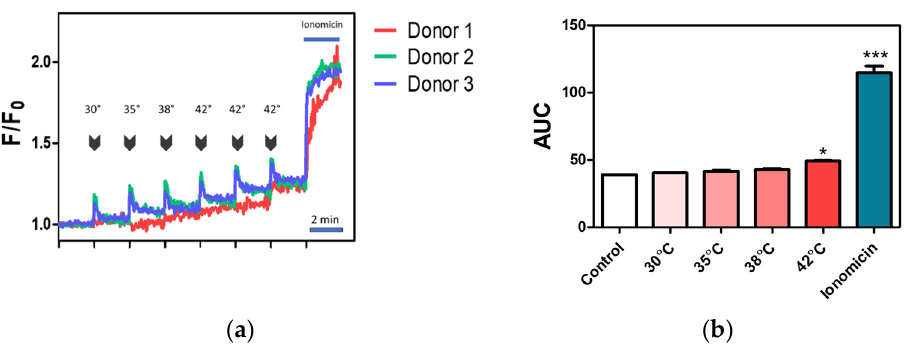
Figure 5. Temperature effect on intracellular calcium levels. ( a ) Relative calcium levels were measured using fluorescent calcium indicator Fluo-4. An increase in temperature was associated with raise in fluorescence intensity (associated with an increase in calcium levels). Ionomycin was used as a positive control. Calcium traces are presented as F/F0 ratio, n = 3. ( b ) Short (3 min) preincubation of cells at 42 °C temperature caused a significant increase in fluorescence intensity associ- ated with raise in intracellular calcium levels. Ionomycin at final concertation of 1 ng/mL caused a further increase in intracellular calcium. Bars represent mean ± s.e.m., n = 3 of the area under the curve (AUC) of calcium traces. Significant differences were denoted with asterisks, depending on the p- level: * p < 0.05, *** p < 0.0001 (one-way ANOVA, followed by Dunnett’s post hoc